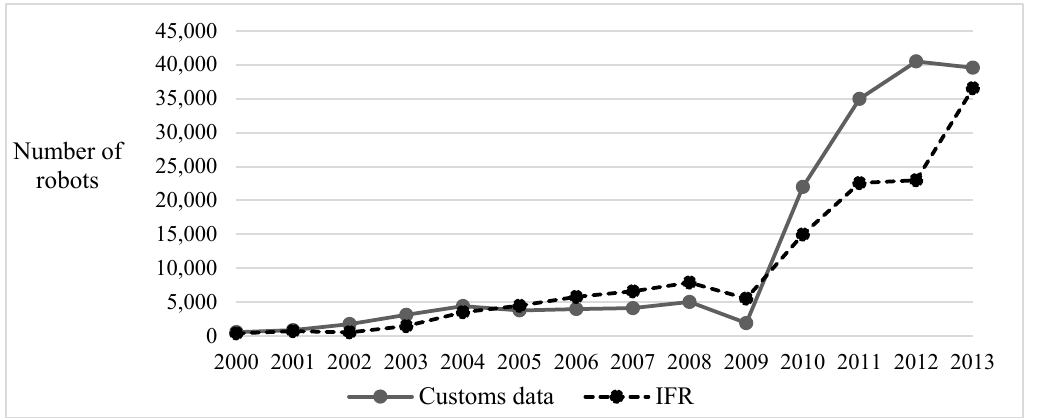
Figure 2. Comparison of the number of industrial robots used and imported in China.